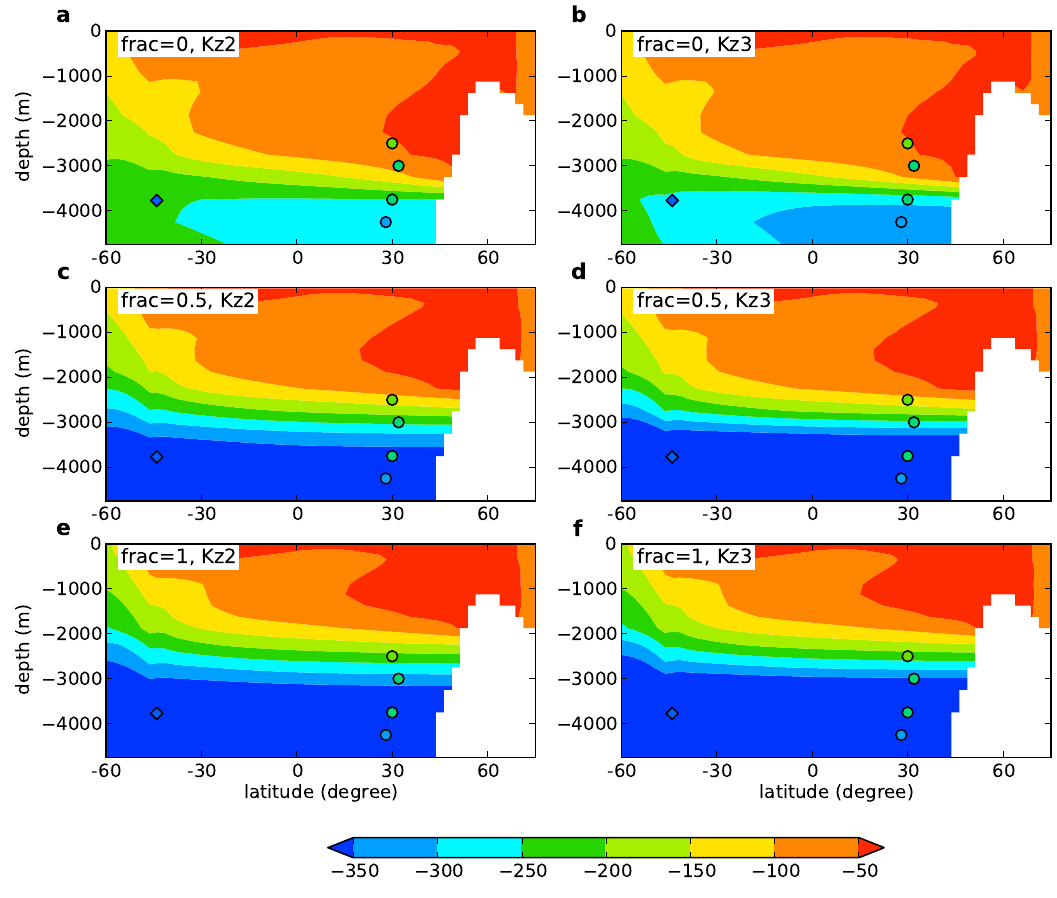
14 C − 1 ) ). The dots represent the LGM DIC